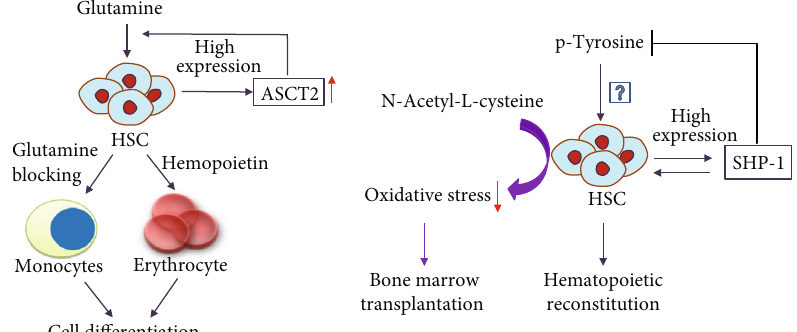
Figure 4: E ff ect of amino acids on the properties of hematopoietic stem cells